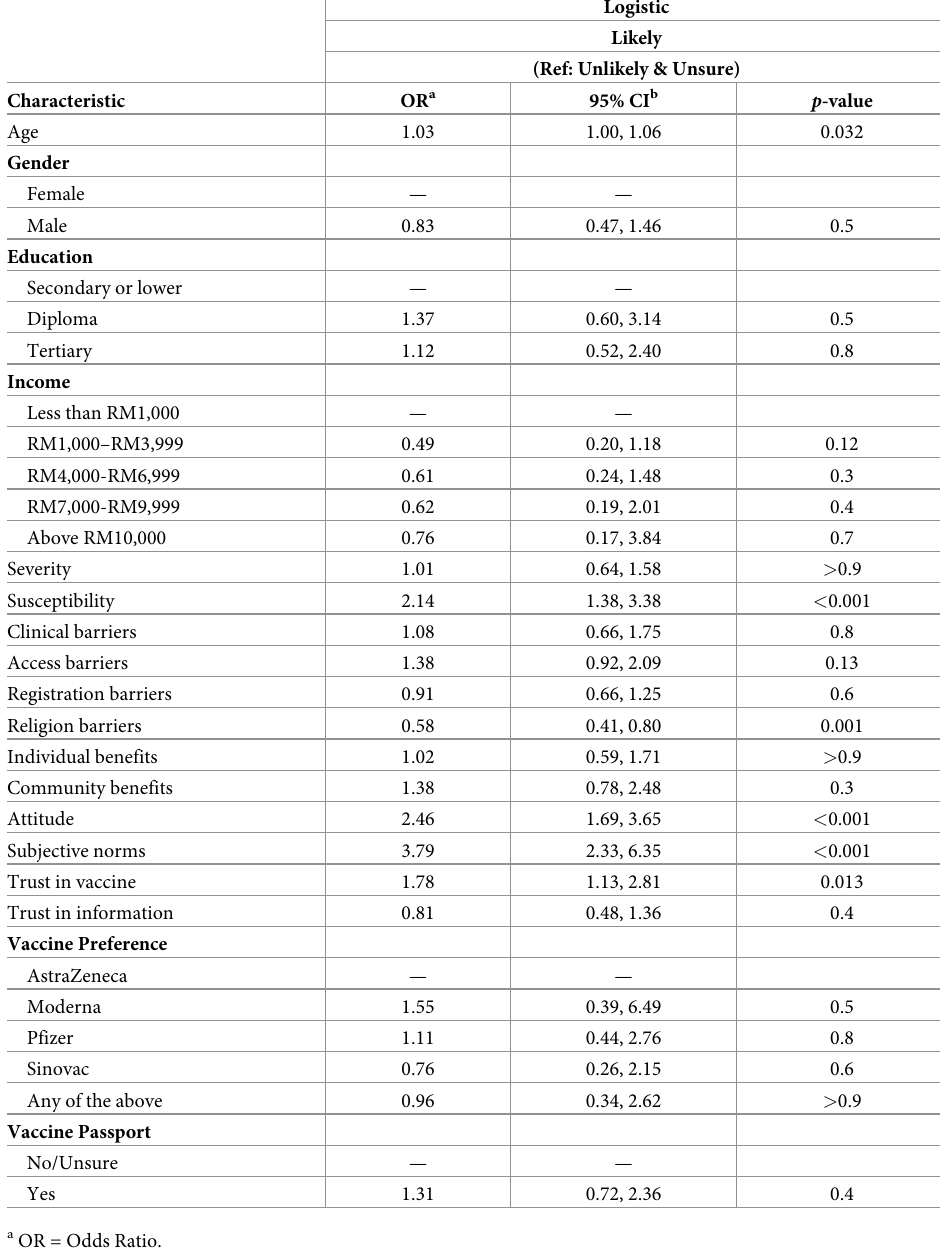
Table 2. Logistic regression model of COVID-19 vaccine intention.